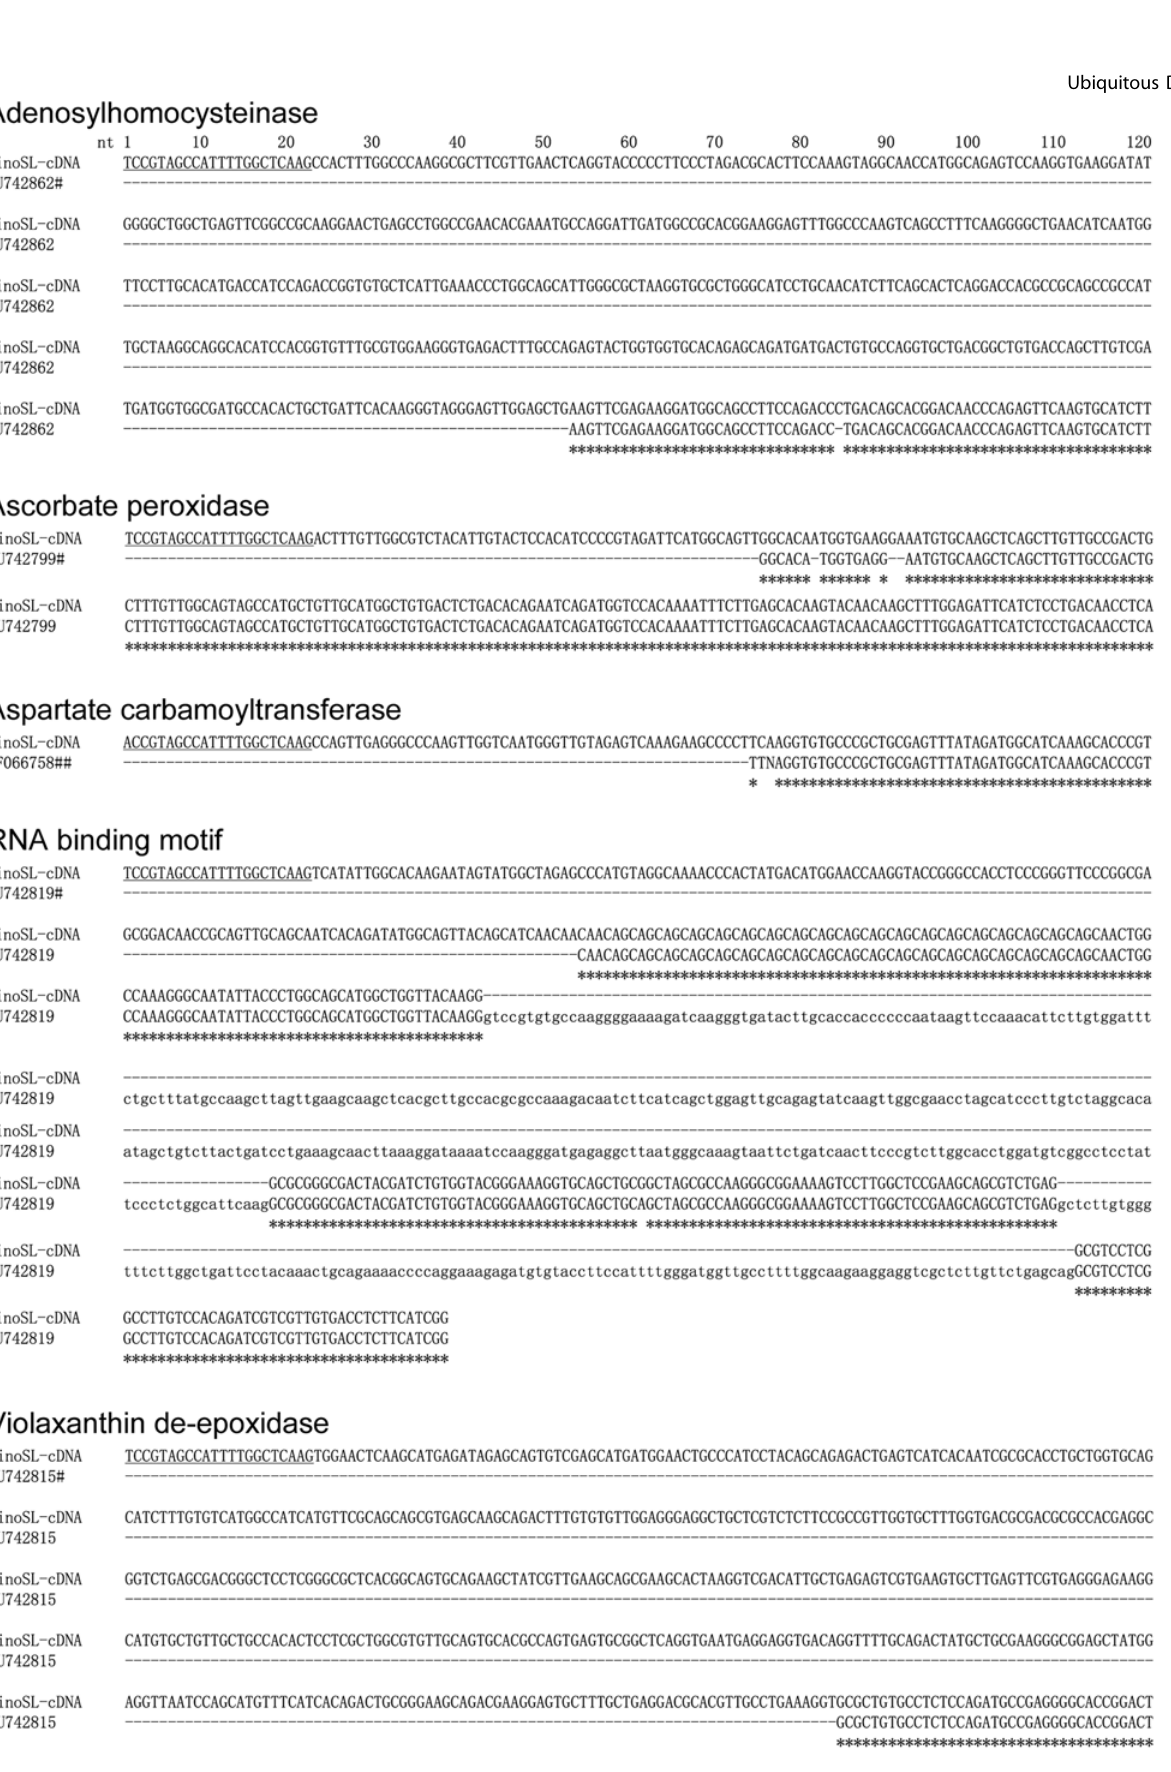
Figure 2. Alignments of the DinoSL-containing cDNAs obtained in this study (DinoSL) with their corresponding genomic ( # ) or cDNA sequences ( ## ) reported previously [ 7,9 ] . Exons are shown in upper case while introns in lower case; consensus positions are denoted by asterisks. The 22-nt DinoSL was underlined. Note that in all cases, the previously reported sequences missed varying lengths of sequences at the 5 9 -end. doi:10.1371/journal.pone.0004129.g002 PLoS ONE |